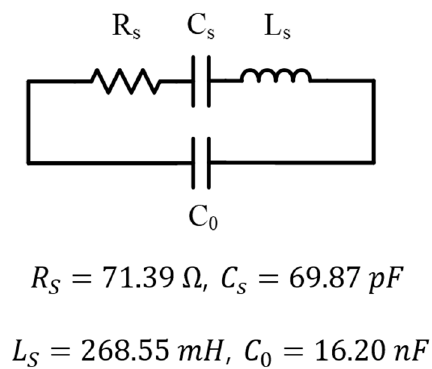
Figure 7. Measurement result of BVD components.